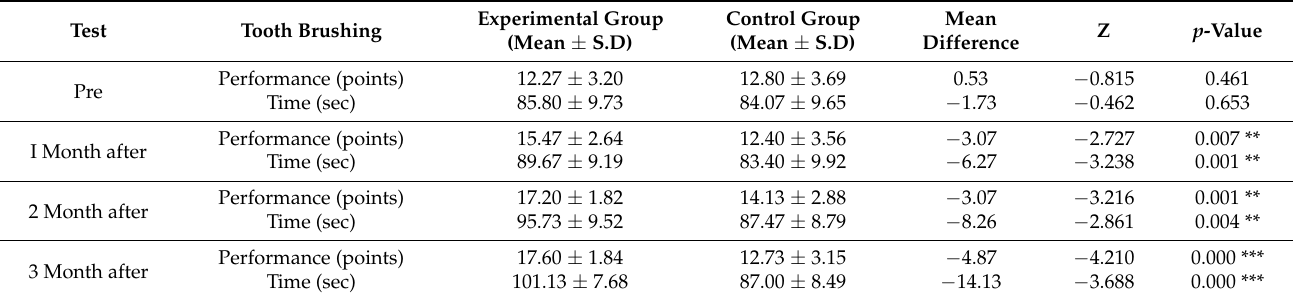
Table 4. The results of tooth-brushing performance and time between 2 groups.